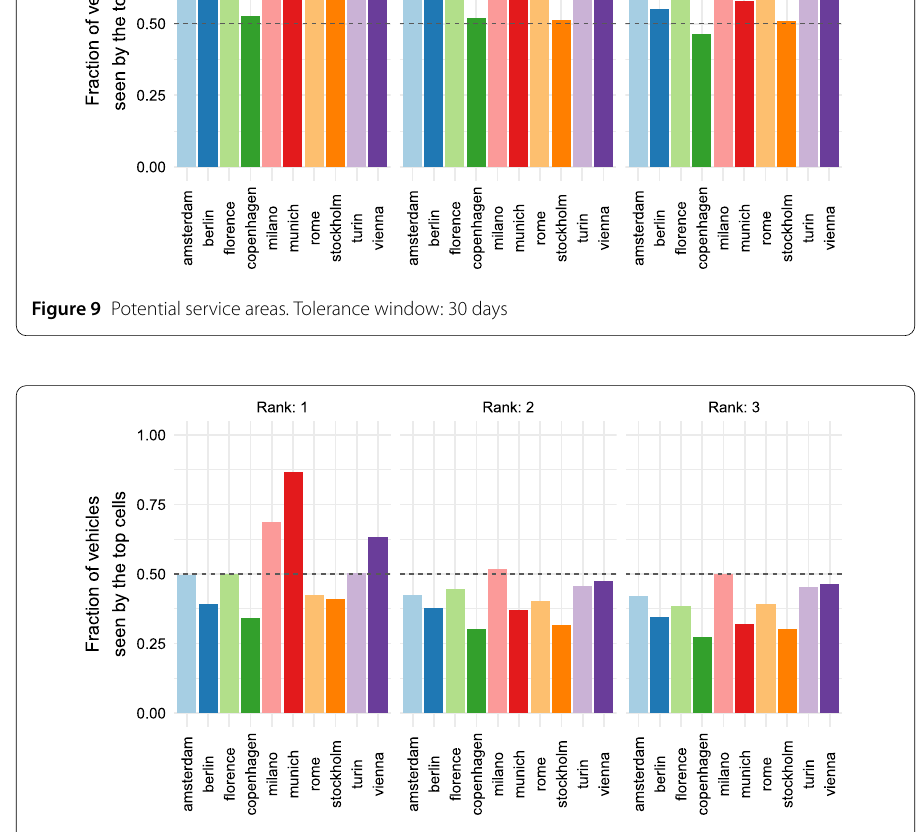
Figure 10 Potential service areas. Tolerance window: 15 days